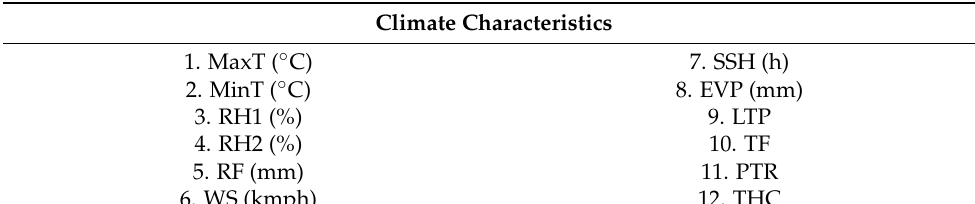
Table 9. Climate characteristics used in Experiment 3.